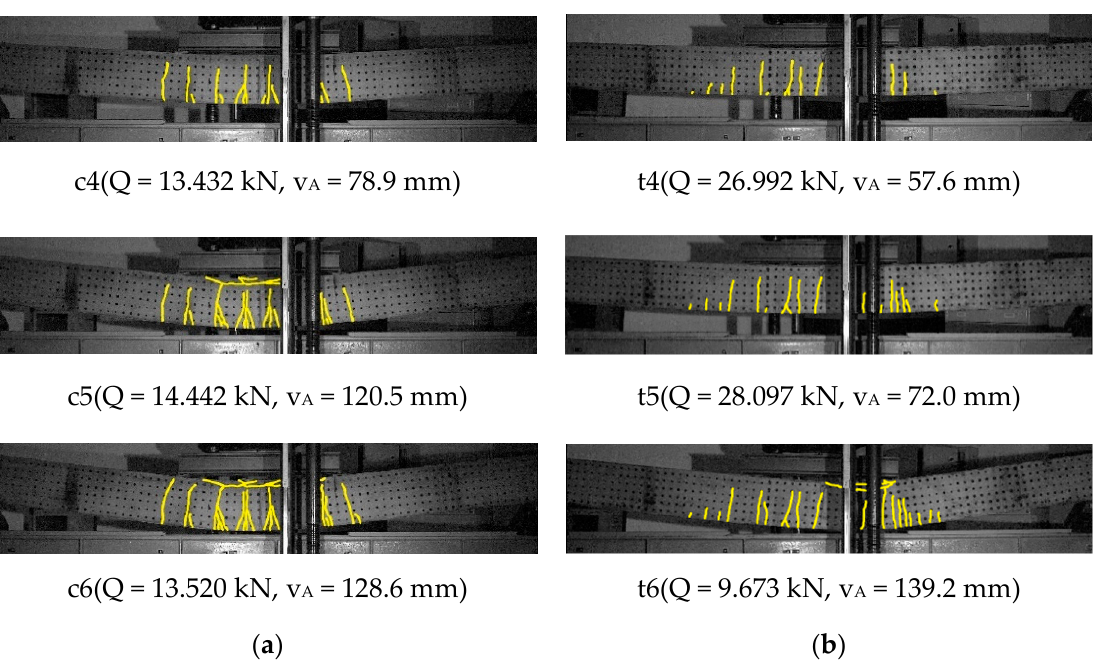
Figure 7. Cracking mechanism of beams of Series 1: ( a ) beam C-s1 , ( b ) beam T-s1 .